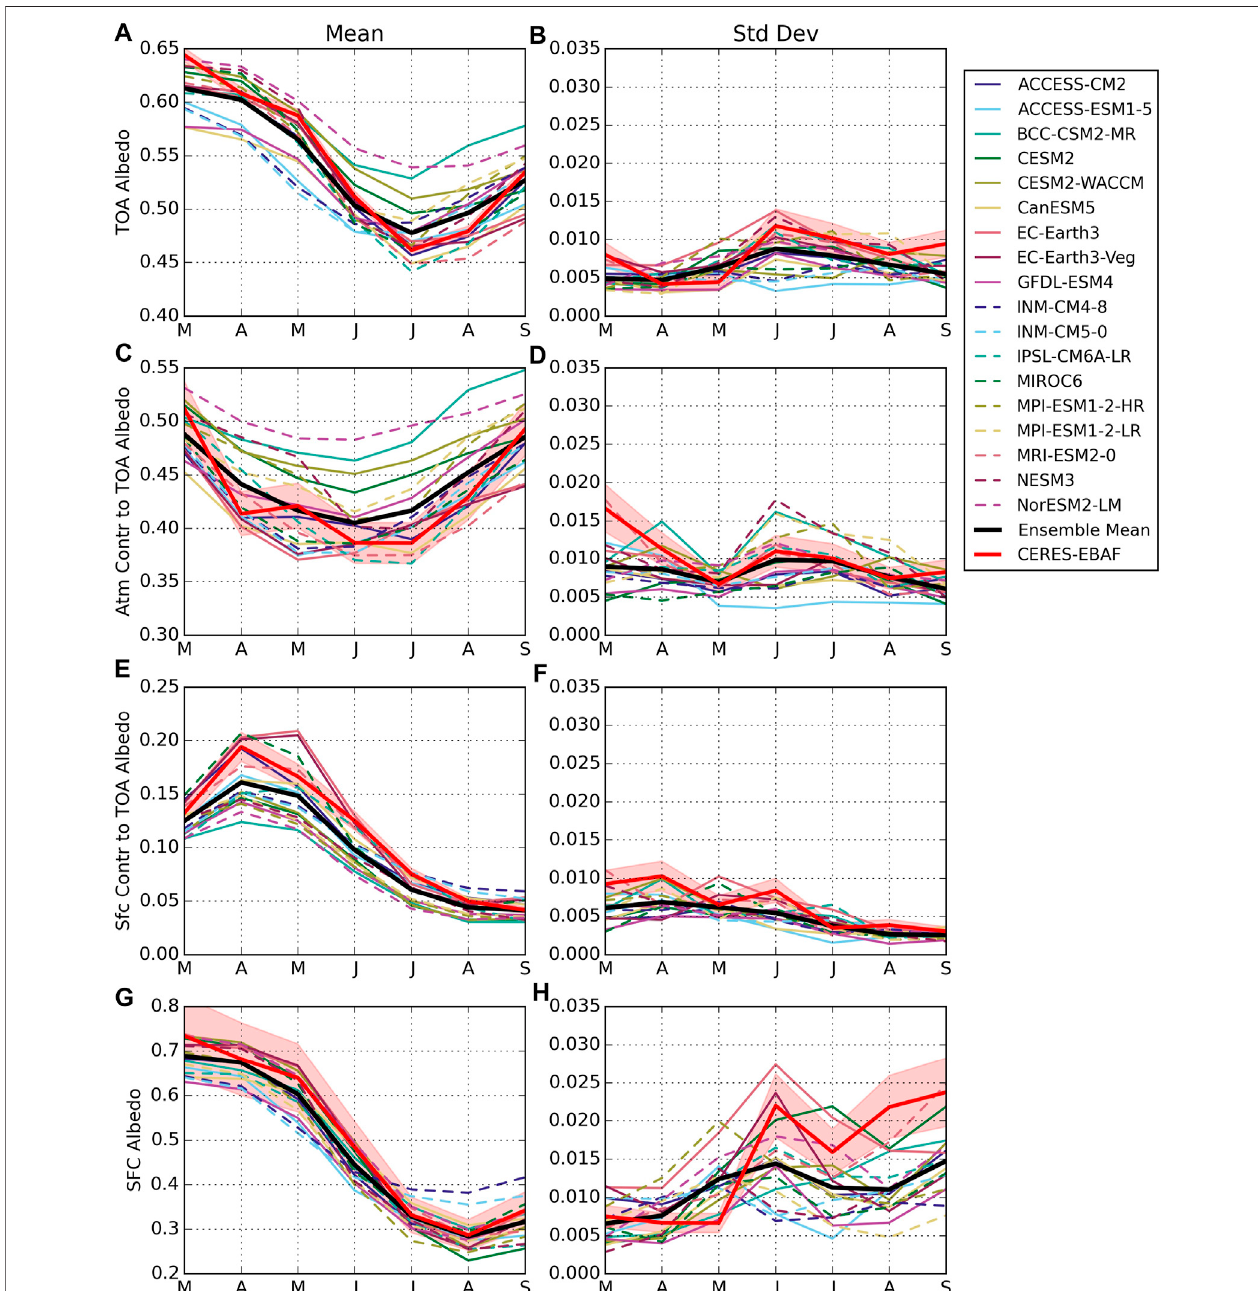
FIGURE2| Monthlymeans (leftcolumn) andstandarddeviations (rightcolumn) ofTOAandsurfacealbedosandTOAalbedopartitionsinCMIP6duringthemelt season, March through September. Values are calculated from historical forcing years 1900 – 2014 and averaged over the area north of the Arctic Circle. Ensemble meansareshowninblack,andobservationsfromCERES-EBAFareshowninred.LightredshadingrepresentsuncertaintyinCERES-EBAF,foundbycalculatingannual fractional errors for each component and multiplying by the monthly values.